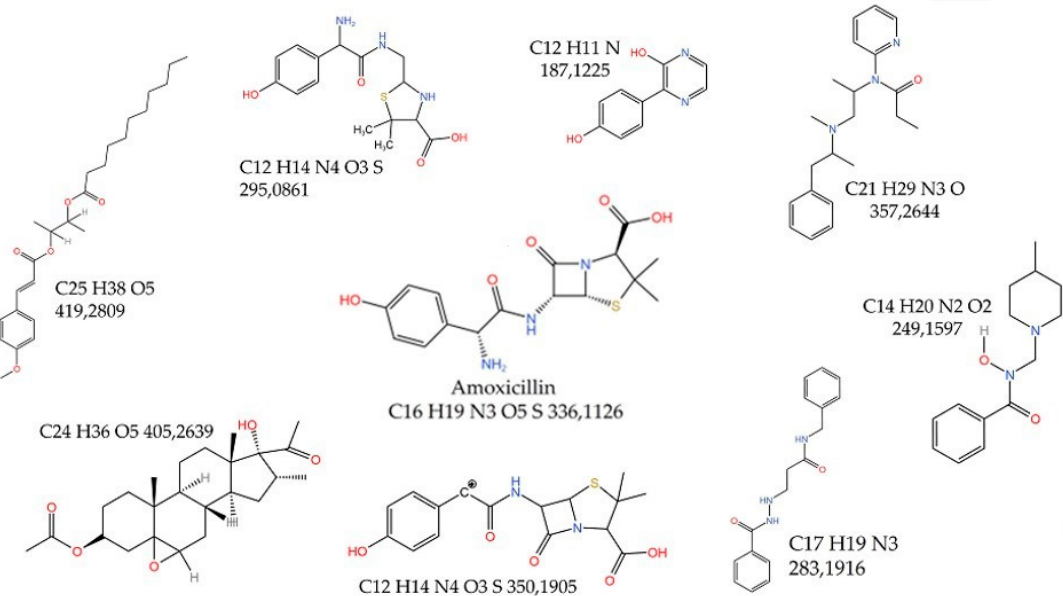
Figure 5. Structures of the identified compounds after 120 min of solar photocatalysis of amoxicillin in CPC reactor over TiO 2 –CNT@PETG static mixer.